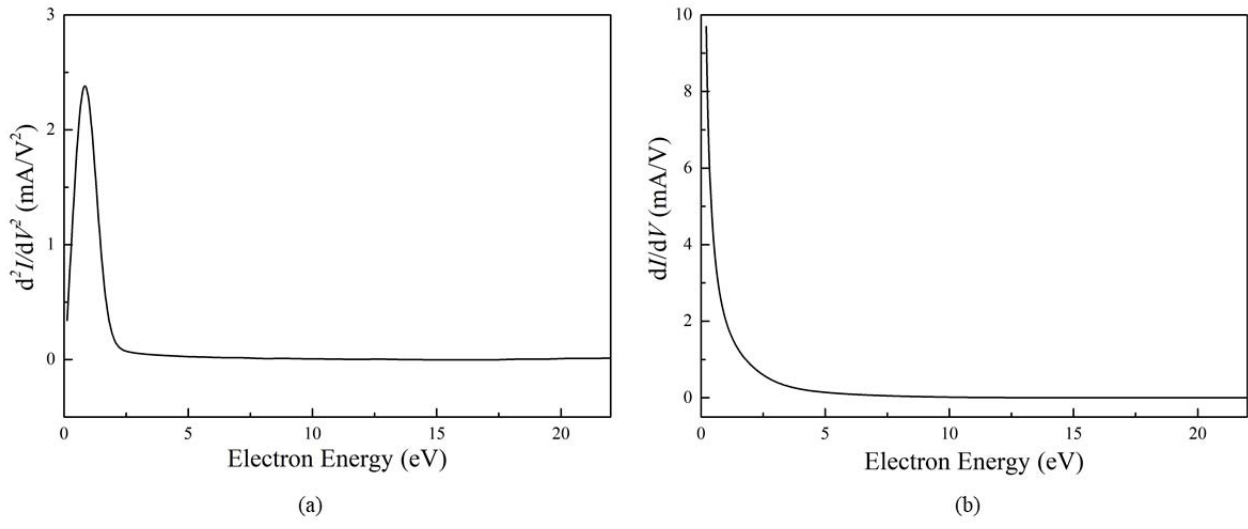
Figure 3. The second ( a ) and first ( b ) derivative of the probe current with respect to the potential for helium at atmospheric pressure with a flow rate of 5 mL/min and the discharge current of 10.7 mA.